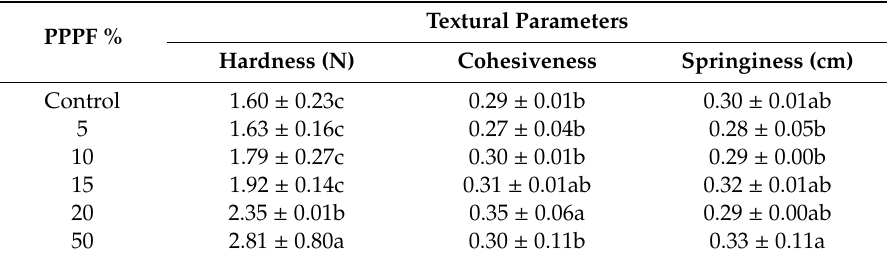
Table 3. Textural properties of dough incorporating prickly pear peel flour (PPPF).